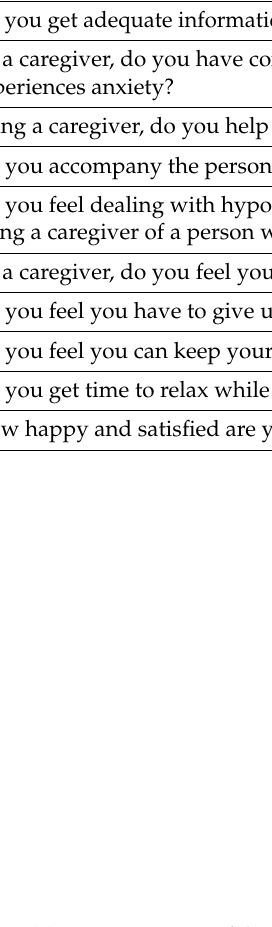
Table 5. Mean scores of the physician, nurse, and diabetes counselor/educator components of the glycemic happiness survey.